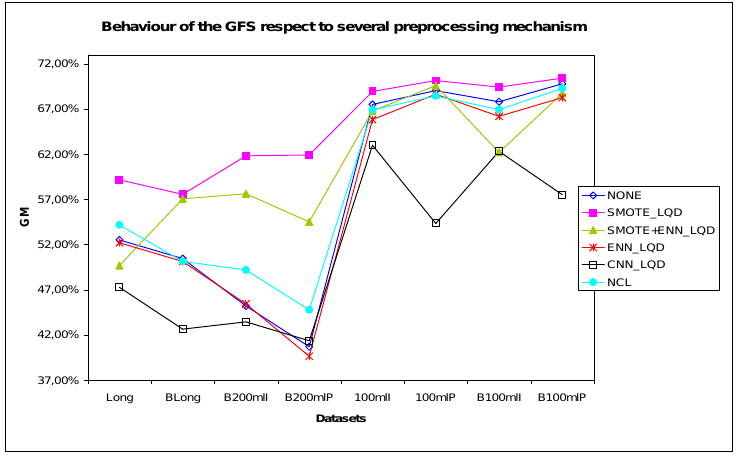
Figure 7: Behaviour of low quality data in the GFS respect to several preprocessing mechanisms (upper bound of GM metric)